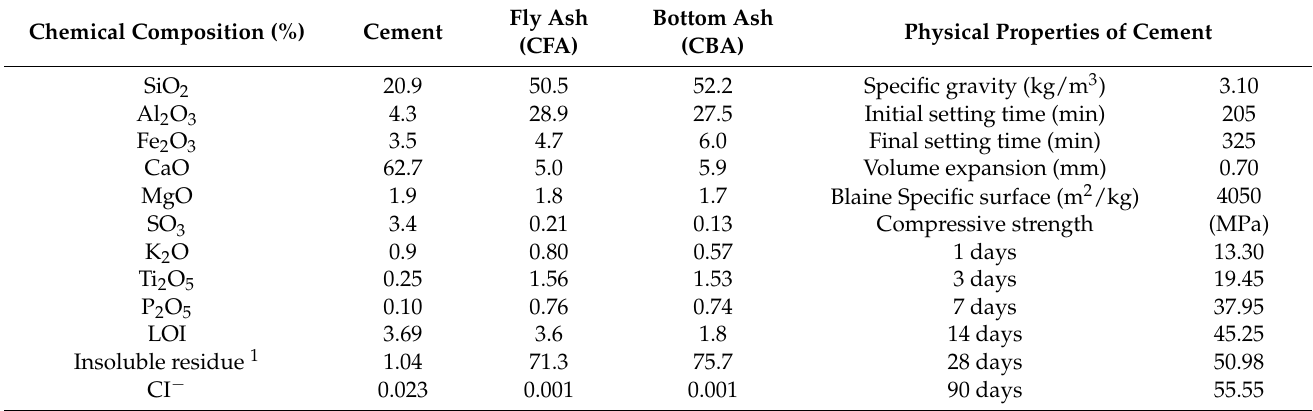
Table 2. Chemical composition of the coal bottom ash (CBA), coal fly ash (CFA) and cement (CEM I 42.5 N). Chemical Composition (%)